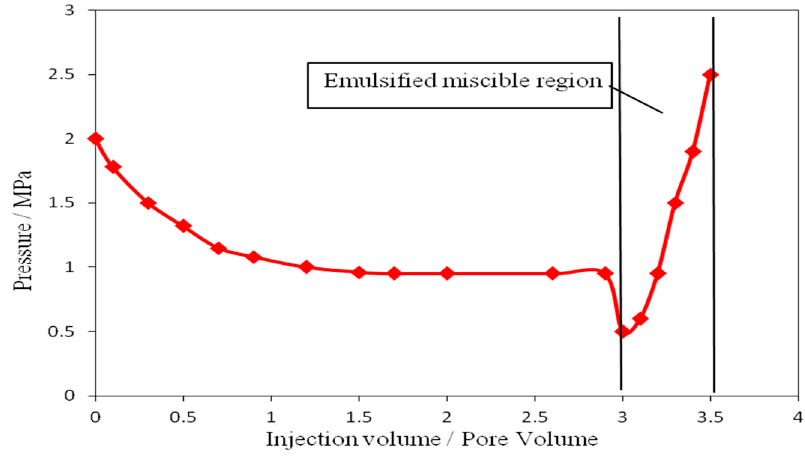
Figure 7. Curve of injection pressure versus injection volume.